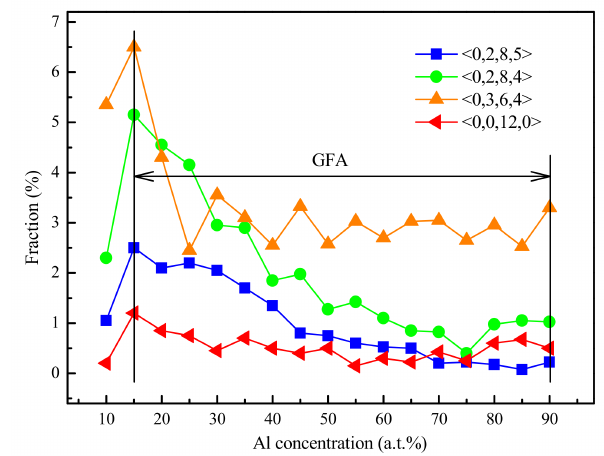
Figure 12. The distribution of main Voronoi clusters in (TiNb 3 ) 1 − x Al x glassy